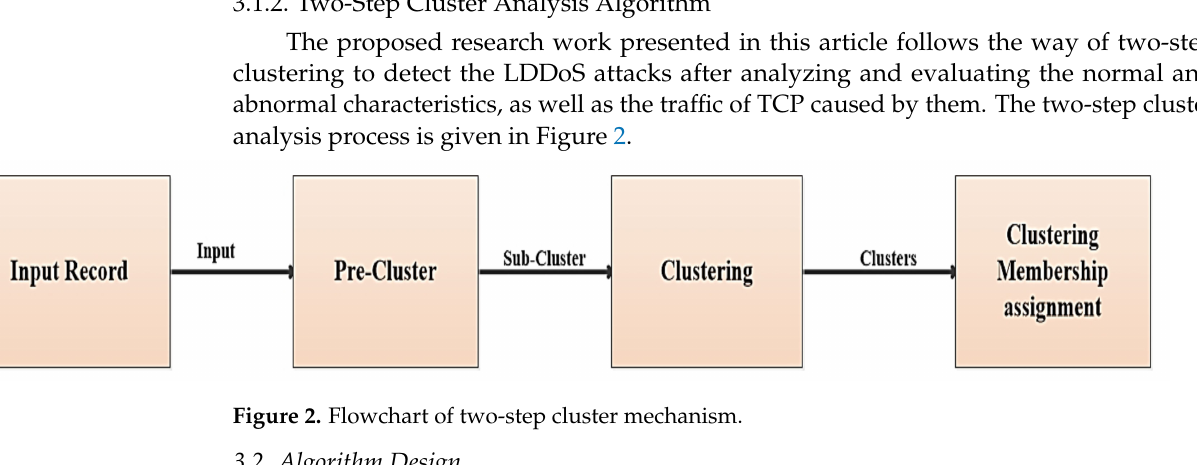
Figure 1. ( a ) TCP traffics under LDDOS attacks; ( b )TCP traffic under no attack; ( c ) TCP traffic under DDOS, general TCP traffic with different environments in a small-time scale [1].